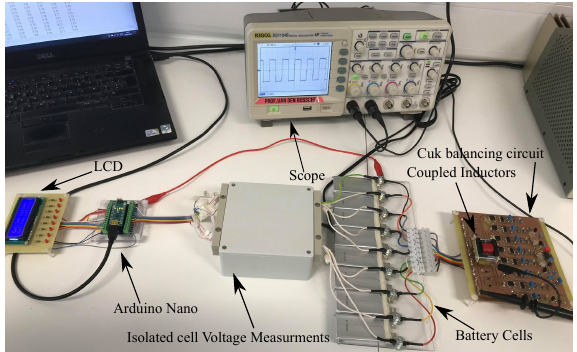
Figure 19. A photograph of the experimental set up of the proposed ´cuk converter balancing circuit.